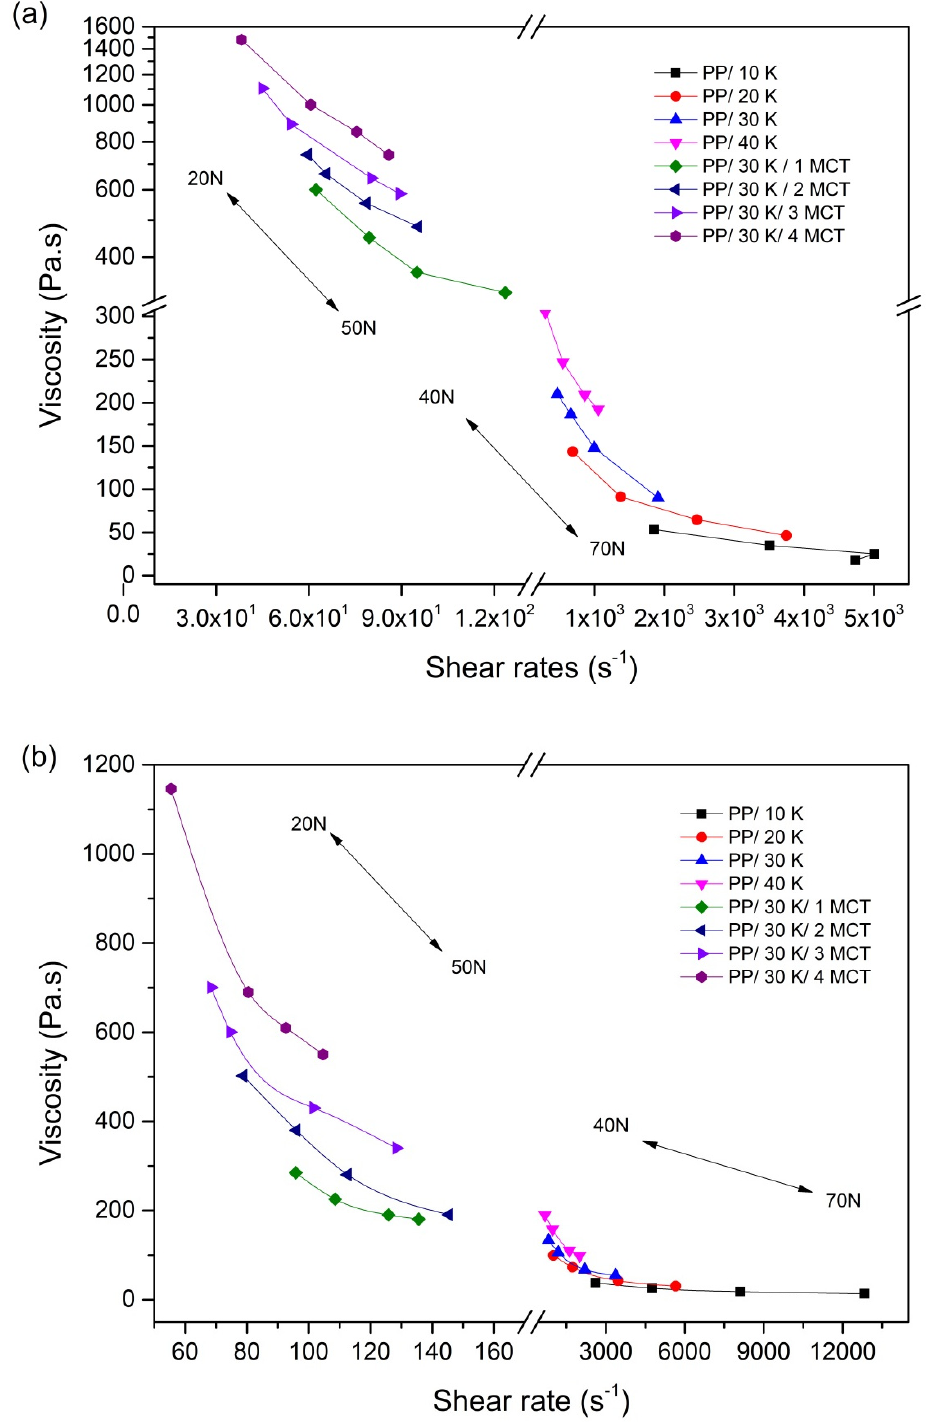
Figure 2. Variations in the melt viscosity of PP/kenaf and PP/kenaf/MWCNT composites at ( a ) 190 °C and ( b ) 200 °C with different shear rates.